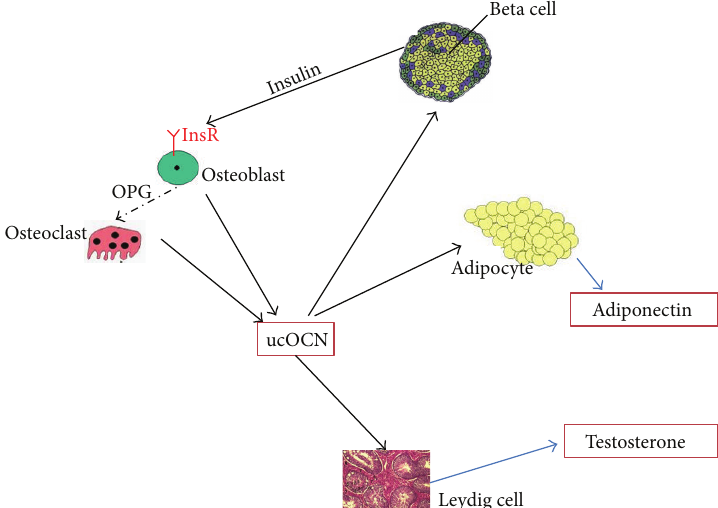
Figure 3: Endocrine actions of osteocalcin. Circulating OCN and particularly ucOCN (released during bone resorption activity) have direct effects on 𝛽 cells, stimulating insulin synthesis. Meanwhile it affects adipocytes and stimulates adiponectin secretion. Adiponectin upregulates insulin sensitivity. In turn, insulin binds to insulin receptor of osteoblasts and affects osteoblasts; then OPG expression will be upregulated and in turn suppress the activity of osteoclasts. Osteoclast stimulates bone resorption with subsequent release of ucOCN in blood circulation. OCN also functions on leydig cells. It can increase their activity and testosterone production. OCN, osteocalcin; ucOCN, uncarboxylated osteocalcin; OPG, osteoprotegerin; InsR, insulin receptor.